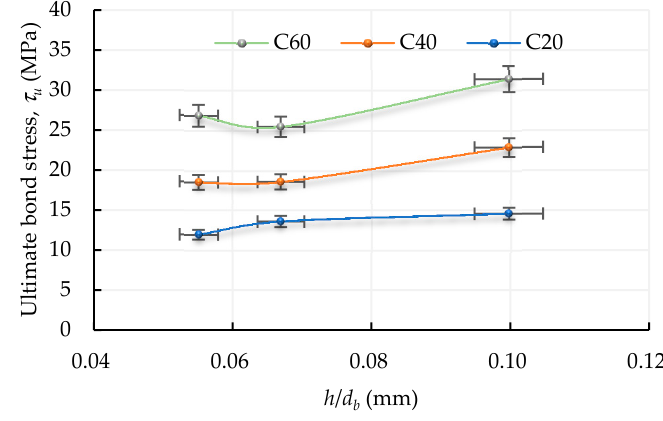
Figure 14. Relationship between h / d b and τ u